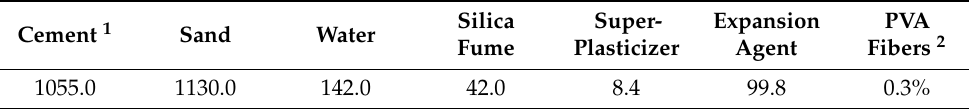
Table 3. Mixture composition of G1 (unit: kg/m 3